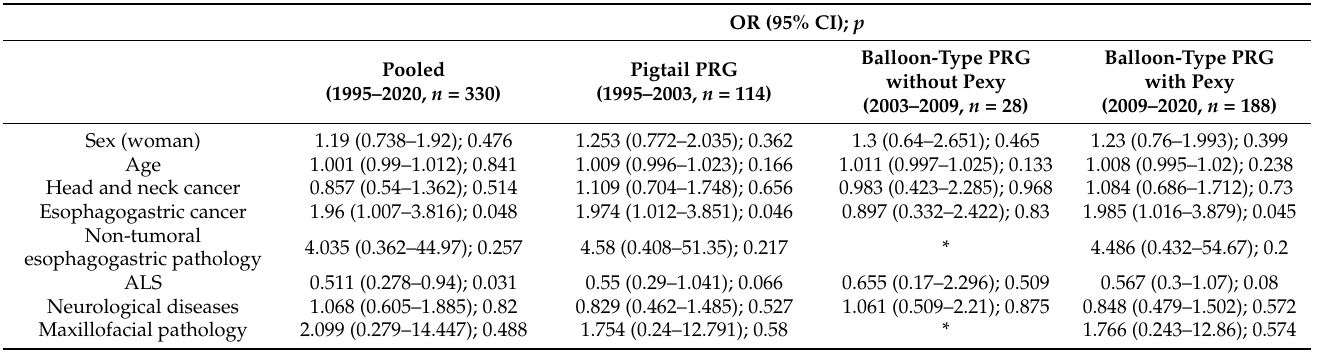
Table 4. Risk factors for total complications after PRG in 330 patients treated at the nutrition unit of the Hospital Universitario Virgen del Roc í o between 1995 and